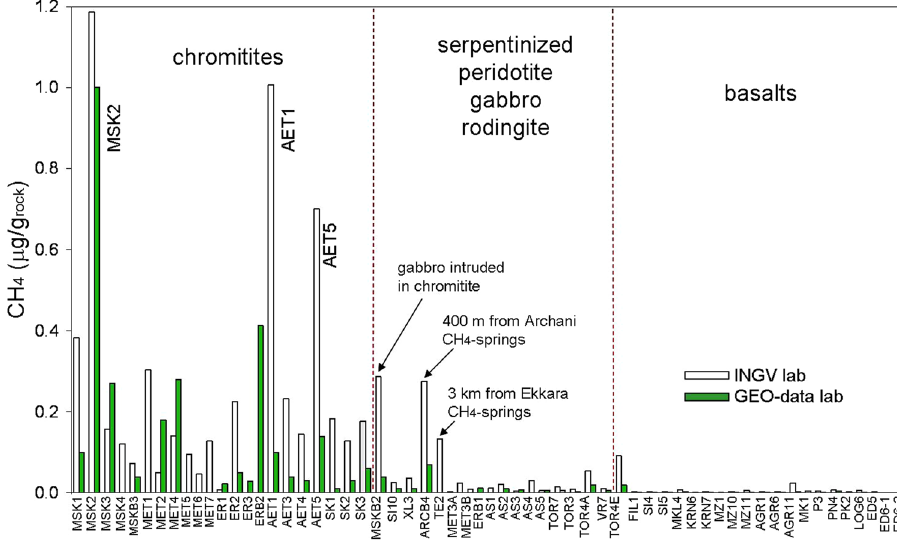
Figure 2. Methane abundance in the investigated ophiolite rocks. The classification of the rocks is based on combining macroscopic and microscopic observations and SEM-EDX microanalyses (see Methods). Sample acronyms are described in Supplementary Table 1.